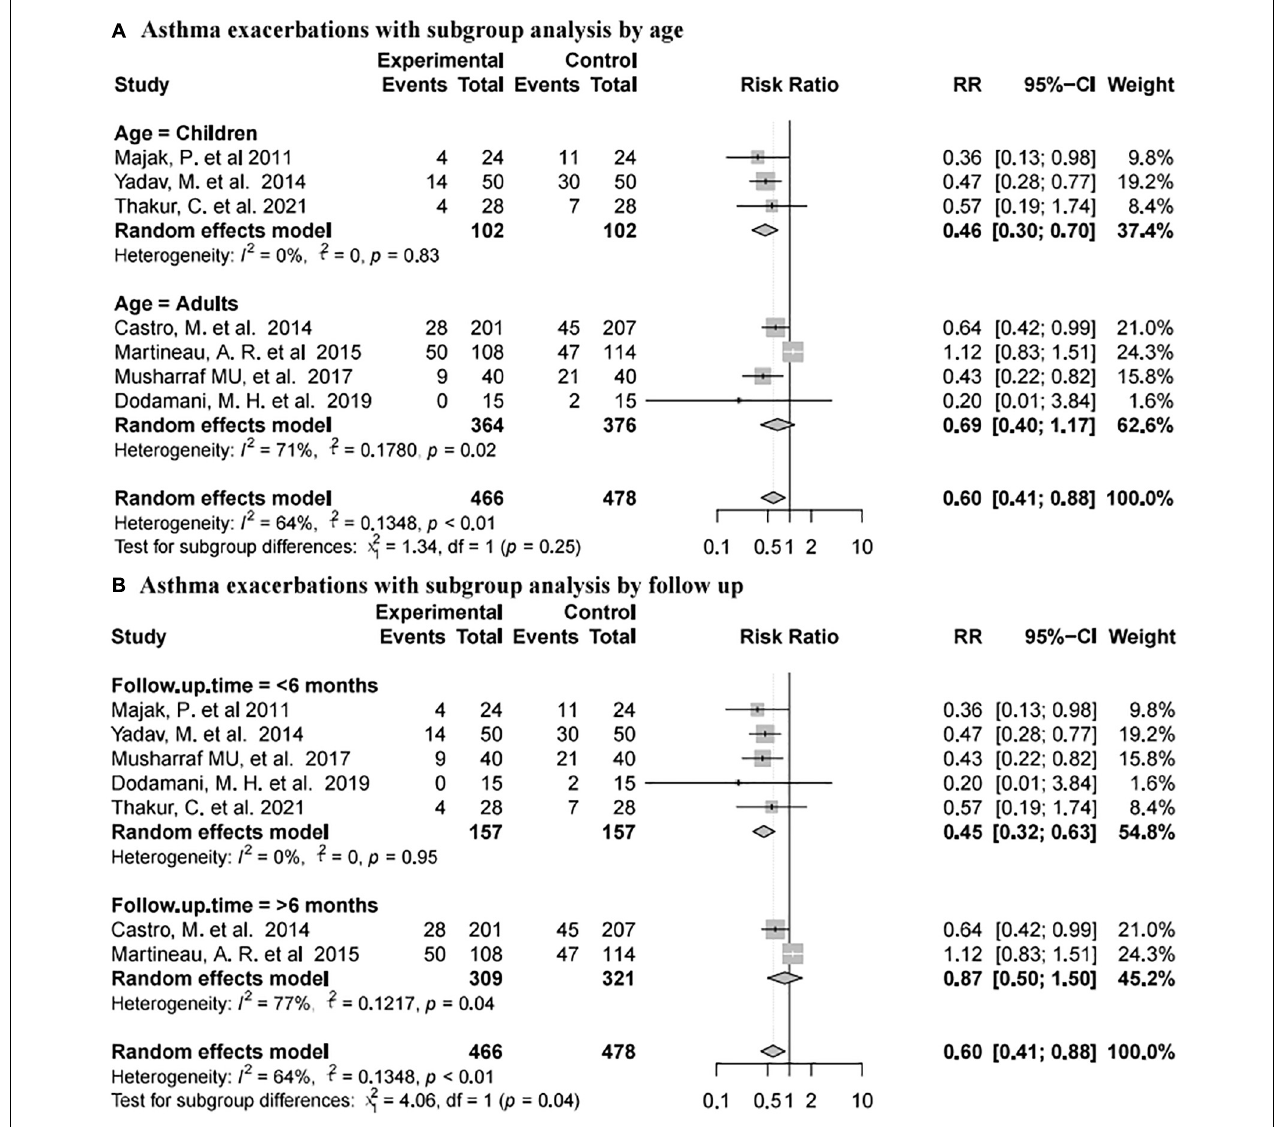
FIGURE 6 | Forest plot random effect model for vitamin D supplementation for asthma exacerbations with subgroup by various factors.